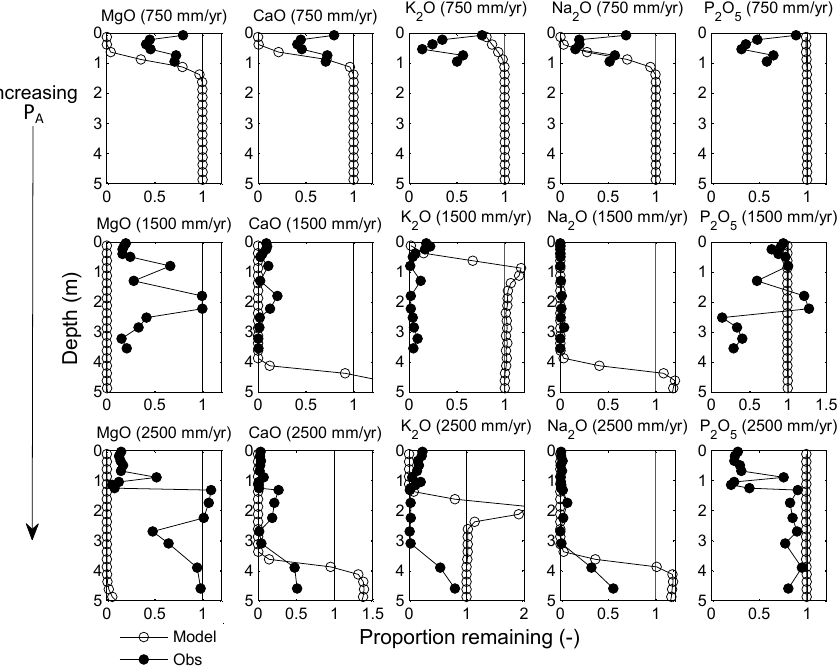
Figure 9. Observed vs. simulated oxide losses/gains across a mean annual precipitation gradient ( P A ) on the 170ka Hawi lava flow. Values < 1 indicate a loss relative to the parent material, and values > 1 indicate relative